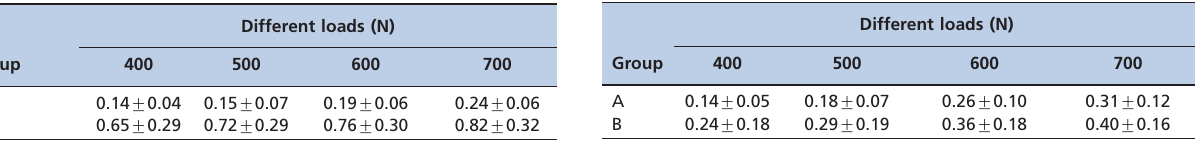
Table 2 - Different loading-lateral displacement of the anterior inferior iliac spine in the standing position (x ¡ s